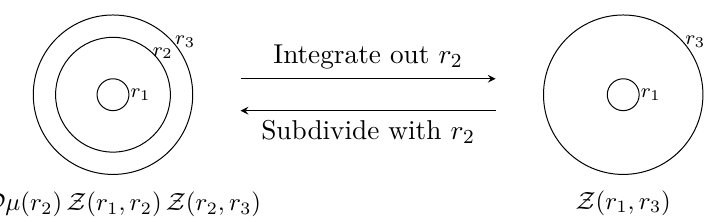
Figure 2 . Refining the perfect path integral Z by arbitrary subdivision(s) the radial direction and integrating out the intermediate variable(s). Discretization independence implies the perfect path integral is invariant under these